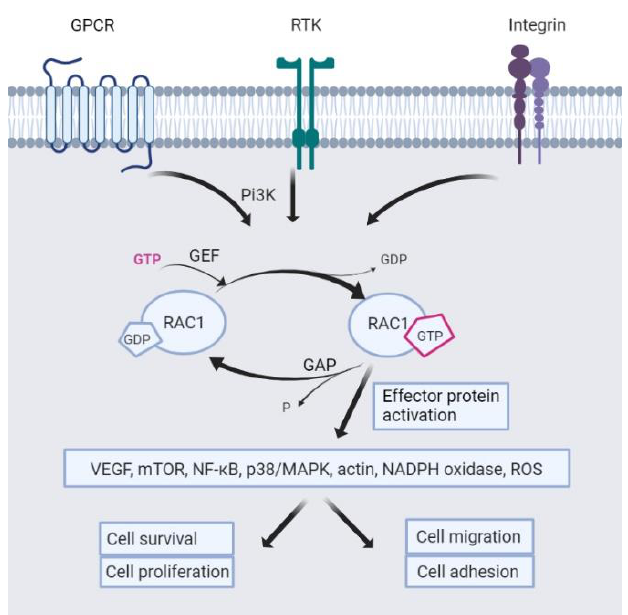
Figure 8 . Rac1 regulation. Depiction of activation and deactivation of the GTPase Rac1 by GEFs and guanine-activating proteins (GAPs). Downstream effector protein activation results in the activation of various signaling pathways, leading to cell survival.